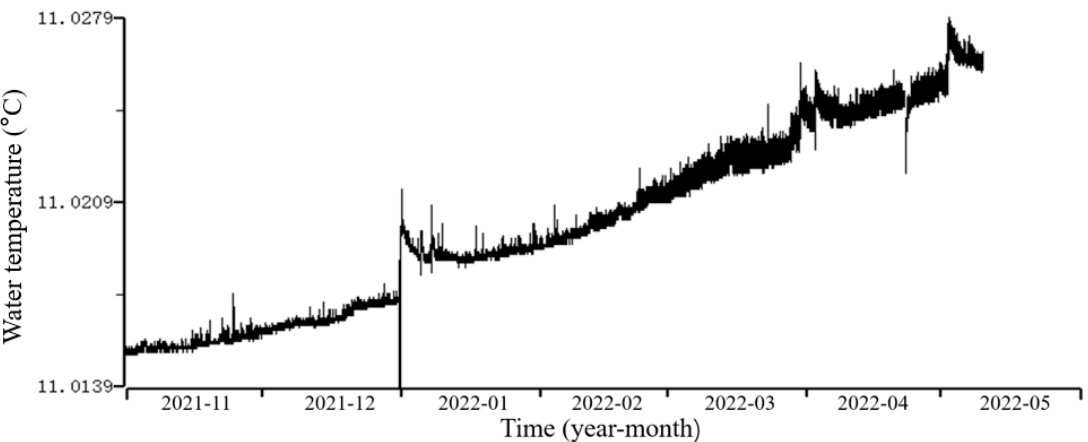
Figure 8. Observation curve of water temperatures at the Lhasa geomagnetic station from November 2021 to May 2022.